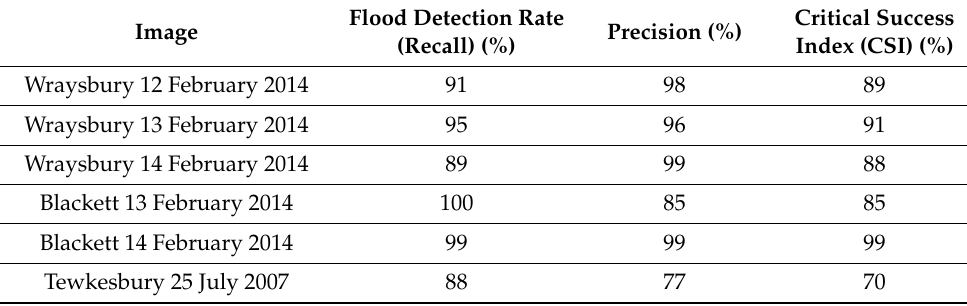
Table 3. Urban flood detection accuracy using rural SAR WLOs and model FRP maps.